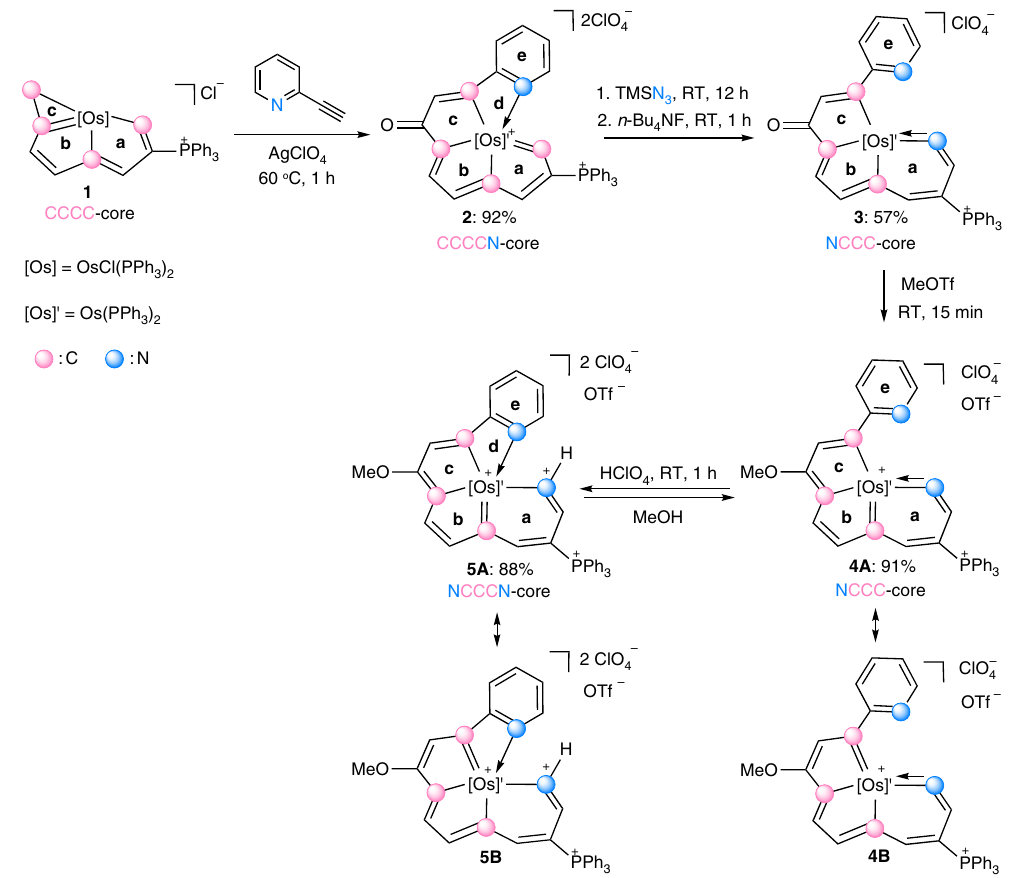
Fig. 2 Successive transformations of polydentate complexes. Transformations of CCCC ( 1 ) to CCCCN ( 2 ), NCCC ( 3 , 4 ), and NCCCN ( 5 ) type